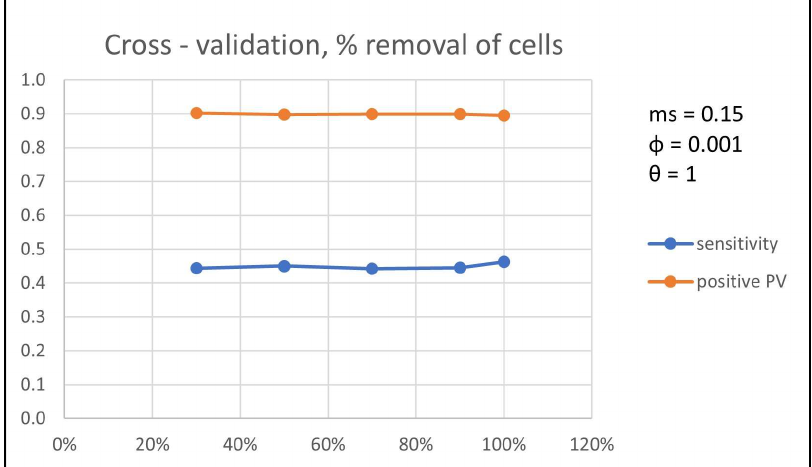
Figure 6. Cross-validation results (with respect to remove percentage, minimum support = 0.15).